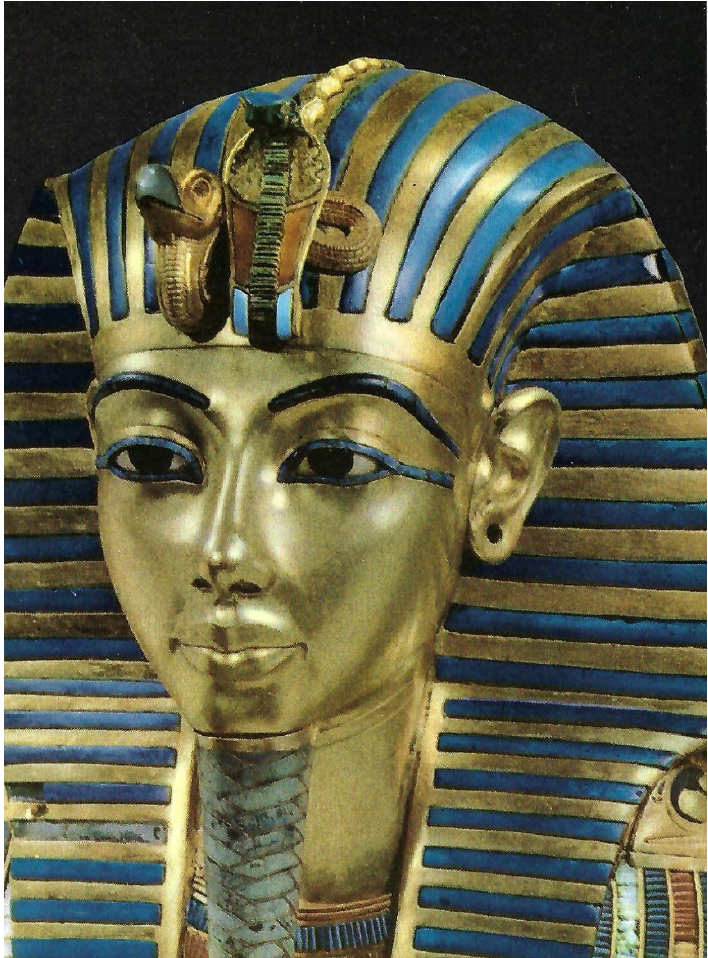
Figure 5. The cobra goddess Wadjet and the vulture goddess, Nekhbet, titulary deities of Lower and Upper Egypt, respectively, adorning the forehead of the third coffin to Tutankhamun, Cairo, The